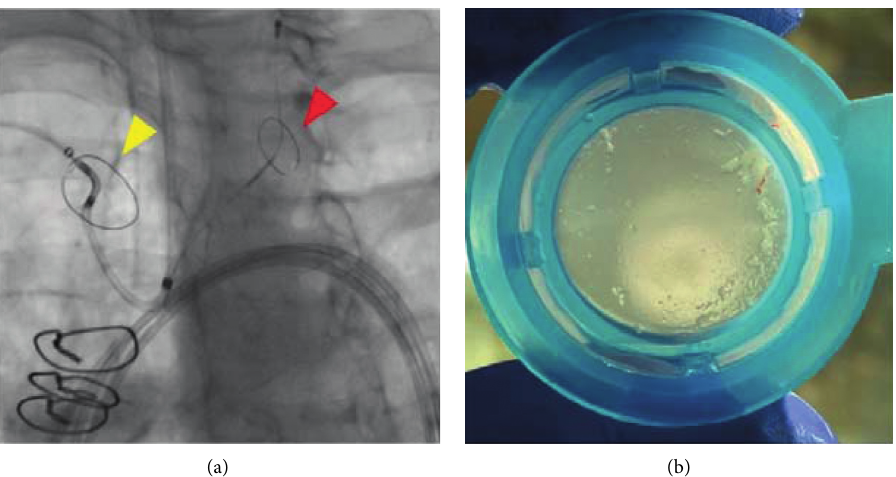
Figure 6: Cerebral protection in ViV-TAVI. (a) Sentinel ® cerebral protection device, implanted with filters in the brachiocephalic trunk and left common carotid artery. (b) Filter from the Sentinel cerebral protection device from a valve-in-valve case showing